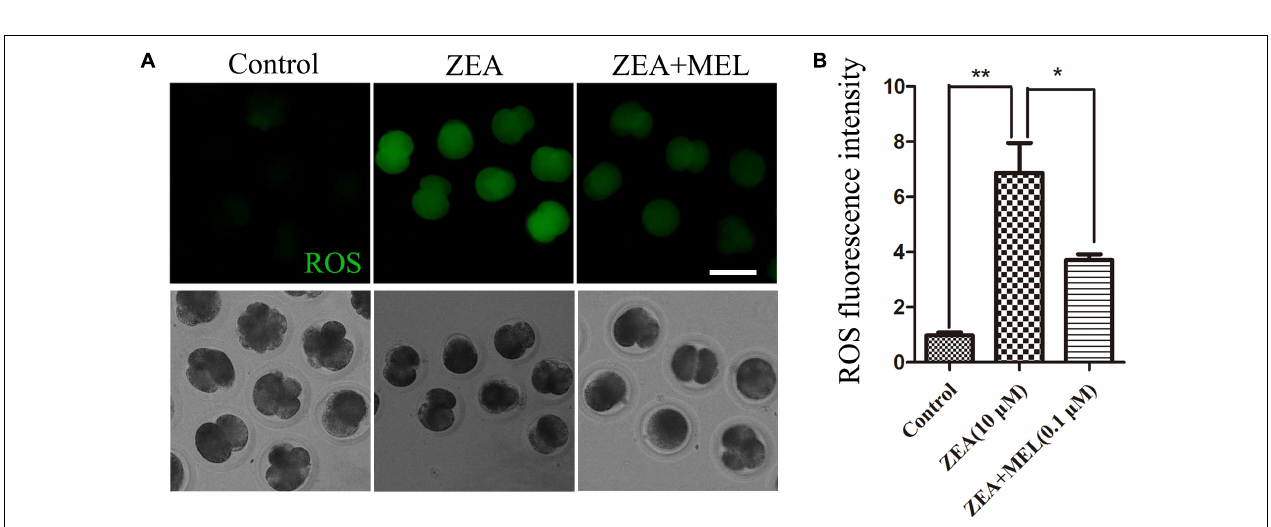
FIGURE 3 | The effect of ZEA and co-exposure of ZEA and melatonin on ROS levels in the porcine embryos. (A) Representative images of DCHF-DA fluorescence (green) in the embryos from the control, ZEA-exposed, and ZEA + MEL groups. Bar = 50 µ m. (B) ROS fluorescence intensity in control, ZEA-exposed, and ZEA+MEL groups, and Fluorescence images were measured by microscope with the same settings and parameters. ∗ P < 0.05 and ∗∗ P < 0.01.